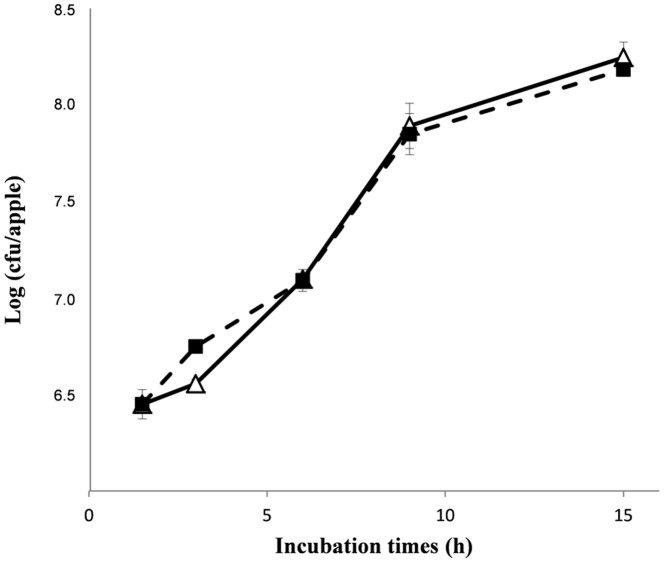
Growth time-courses of Pichia anomala Kh6 in the presence (triangle) or absence (filled square) of Botrytis cinerea using the apple model.Vertical bars indicate the standard deviation of the log (cfu/apple) determined as a mean of 3 measurements.